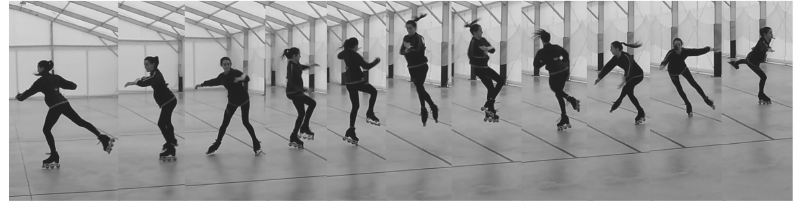
Figure 6. Double Salchow. Max height detected: 28.8 cm.